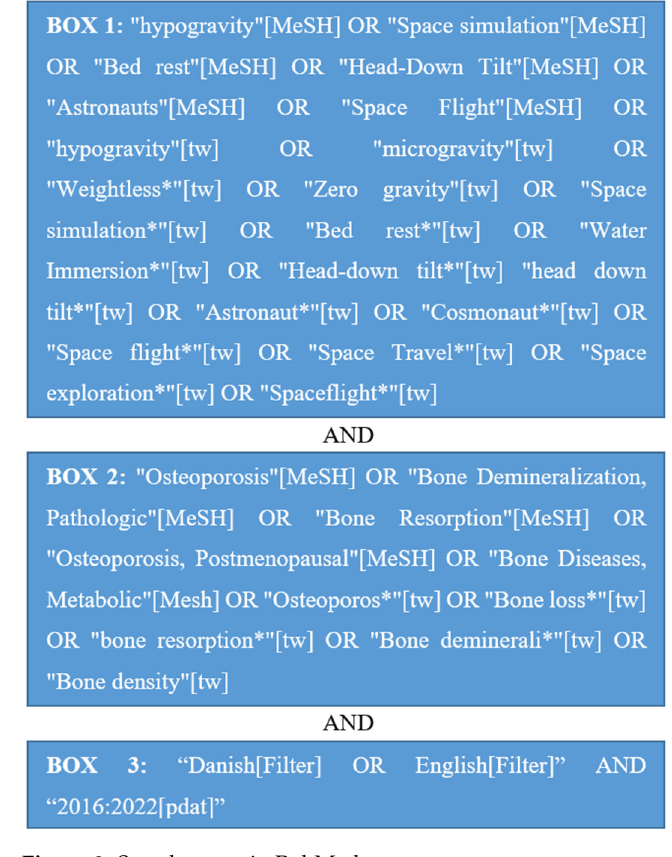
Figure 4. Flowchart of study selection.